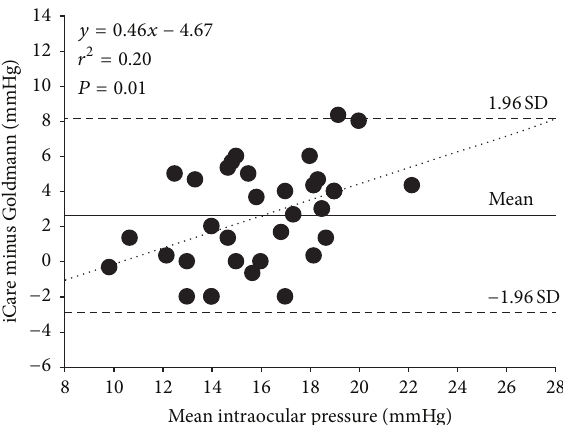
Figure 2: Difference versus the mean plot illustrating the comparison between IOP measurements taken with GAT and iCare tonometer. The iCare tonometer significantly overestimated IOP compared to the GAT. The solid line represents the mean bias, and the dashed lines represent the 95% limits of agreement.